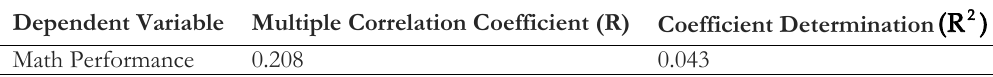
Table 5. Predictive coefficients of dependent variable